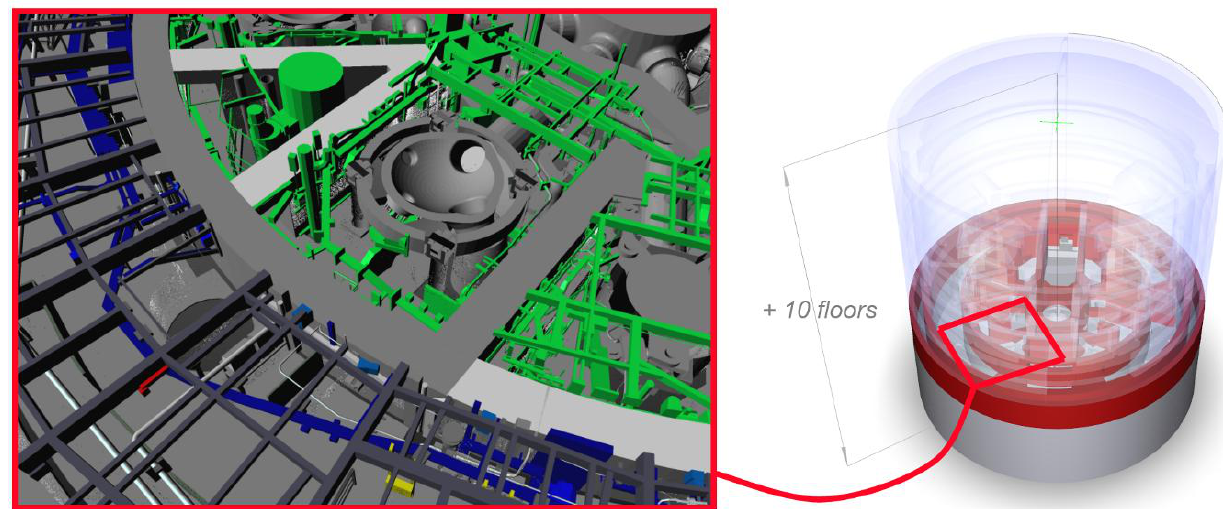
Figure 8: 3D as-built reconstruction of a large industrial installation. Left : detailed view of the as-built CAD model of one floor. Right : concrete parts of the building and location of the detailed viewport. Regarding the display, taking advantage of last computer configurations is not enough to handle very large data sets: improvements of data management, data compression and data access are still expected. However, recent developments in out of core mechanisms allowed us to navigate through the 40.10 9